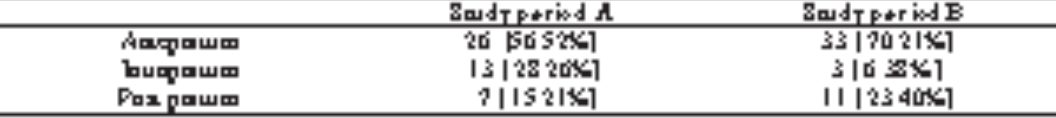
Majority of patients developed fits before delivery during both study period, but relatively more cases came